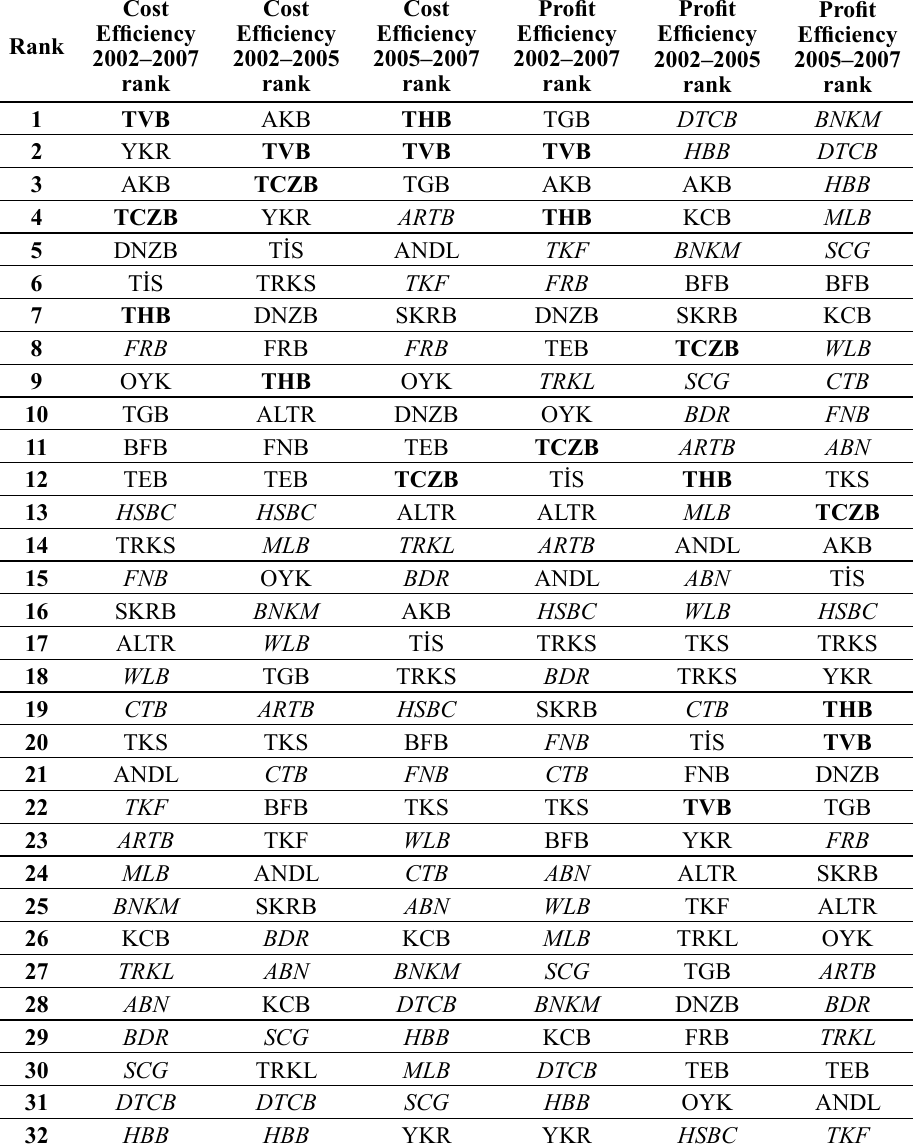
Table 6. Efficiency Ranks of the